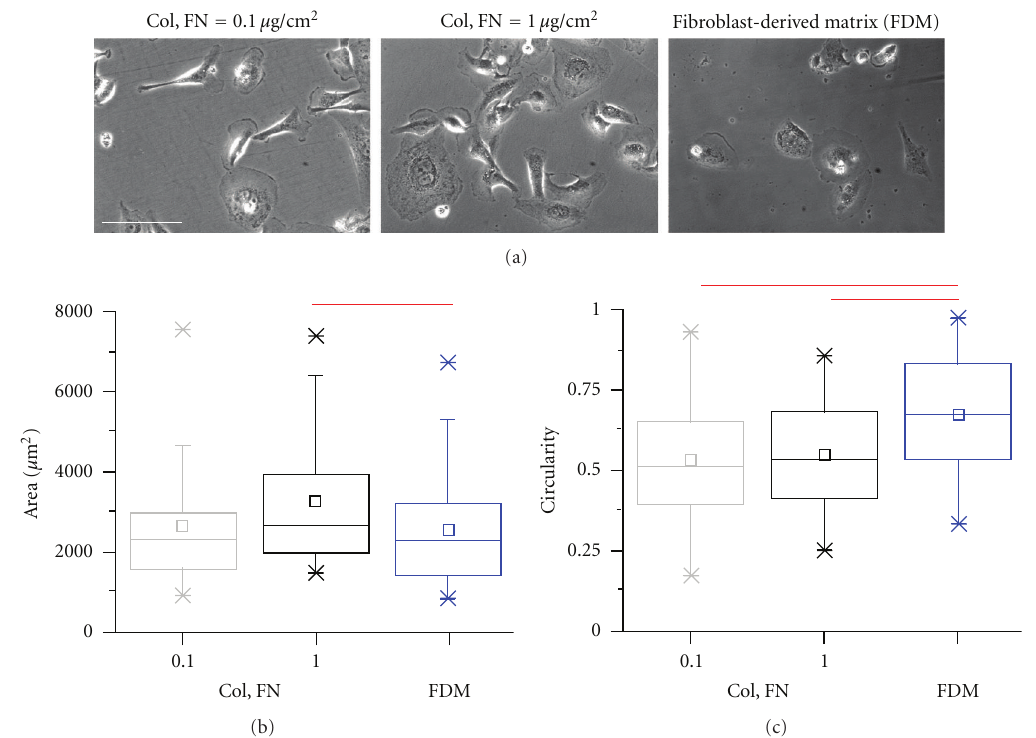
Figure 7: Morphometric analysis of MDA-MB-231 cells on mixed ECM surfaces. (a) Representative phase contrast images of MDA-MB-231 cells cultured for 24 hours on coverslips coated with 0.1 μ g/cm 2 collagen and fibronectin (Col, FN = 0 . 1 μ g/cm 2 ), 1.0 μ g/cm 2 collagen and fibronectin (Col, FN = 1 . 0 μ g/cm 2 ), and on fibroblast-derived matrix (FDM). Scale bar = 100 μ m. (b) Box whisker plots of projected cell area on di ff erent mixed ECM surfaces. Cells spread to a lesser extent on FDMs. Maximal spreading was observed for Col, FN = 1 . 0 μ g/cm 2 ( ∗ P < 0 . 05). (c) Box whisker plots of circularity measures on di ff erent mixed ECM surfaces. Cells were statistically more rounded on FDMs compared to the other conditions ( ∗ P < 0 .